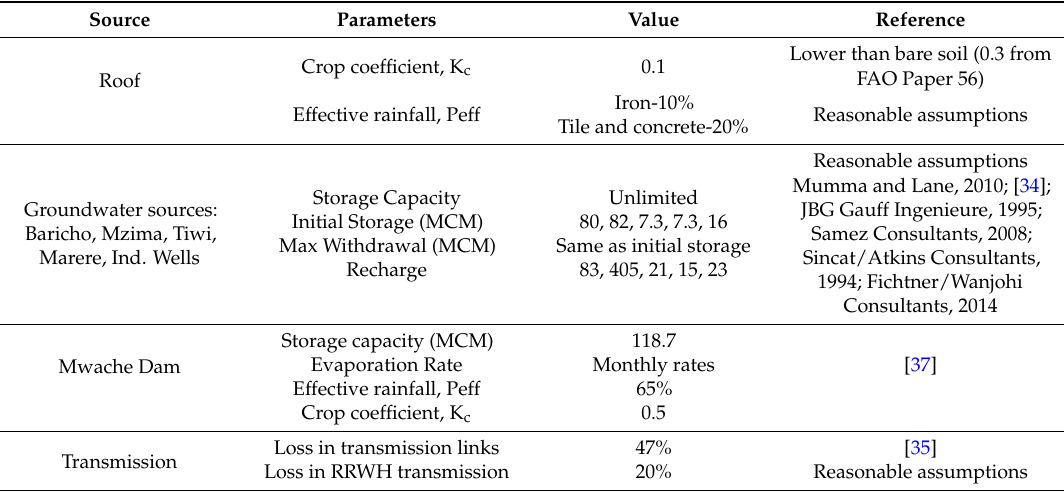
Table 4. Input data for current accounts.